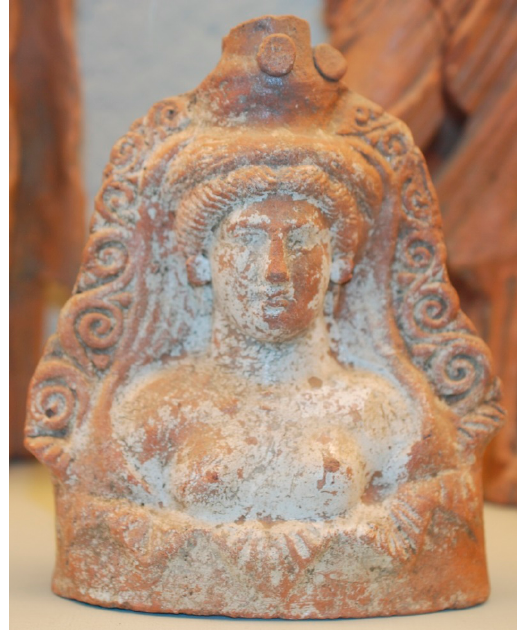
Figure 7. Paestum, Museo Archeologico Nazionale Floral thymiaterion base from the southern urban sanctuary, late 4th century B.C. Author’s photo.